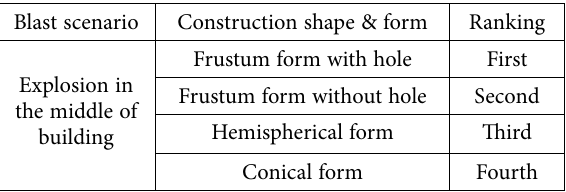
Fig. 24. Von misses composite stress in spherical building in a moment after explosion strikes building in 10 meters high from the roof Table 5. Ranking of the building form by the scenario of explosion in the middle of building